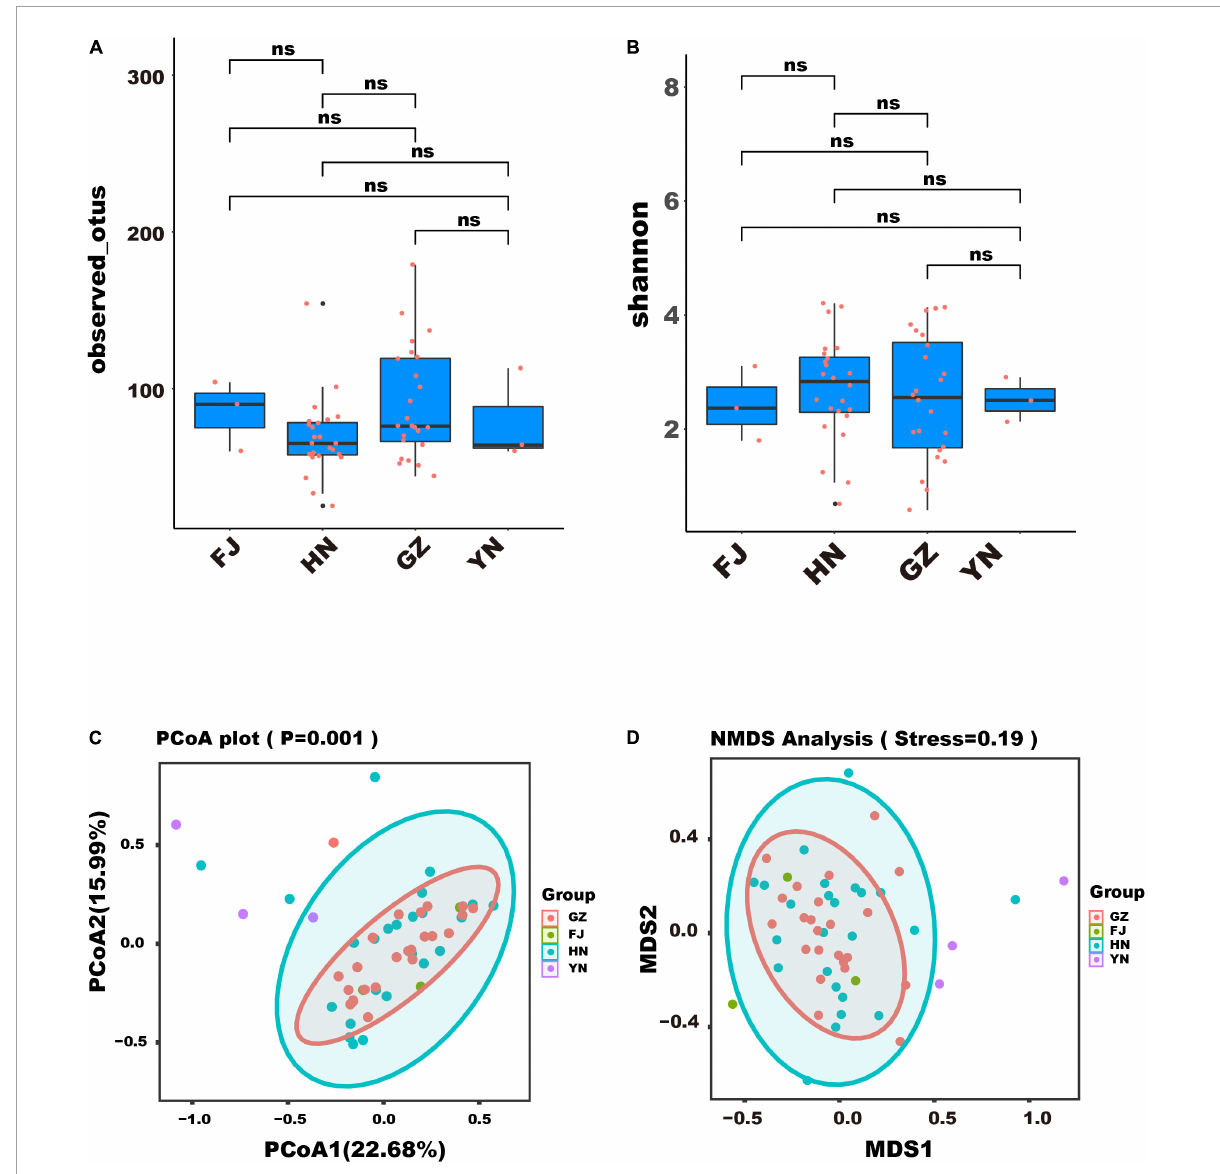
FIGURE3 Diversity analysis of endophytic fungi of Dendrobium nobile from different habitats. (A) The index of observed OTUs; (B) the Shannon index; (C) the result of PCA; (D) the result of